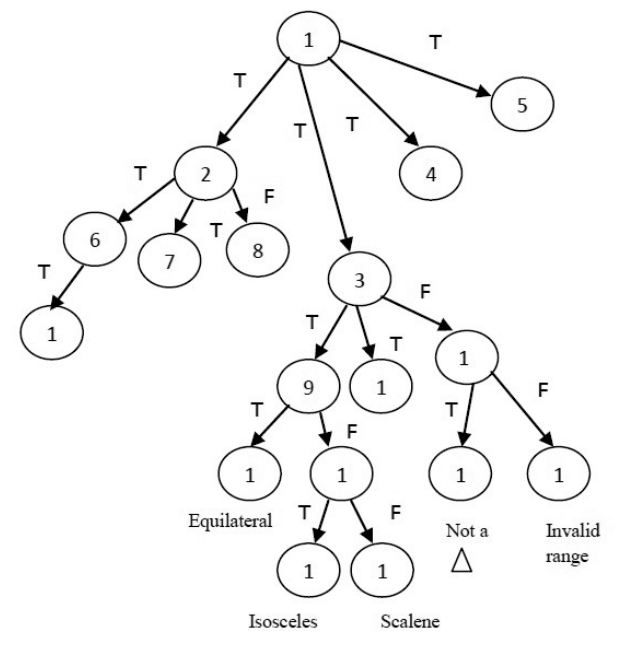
Figure 5. CDG of triangle